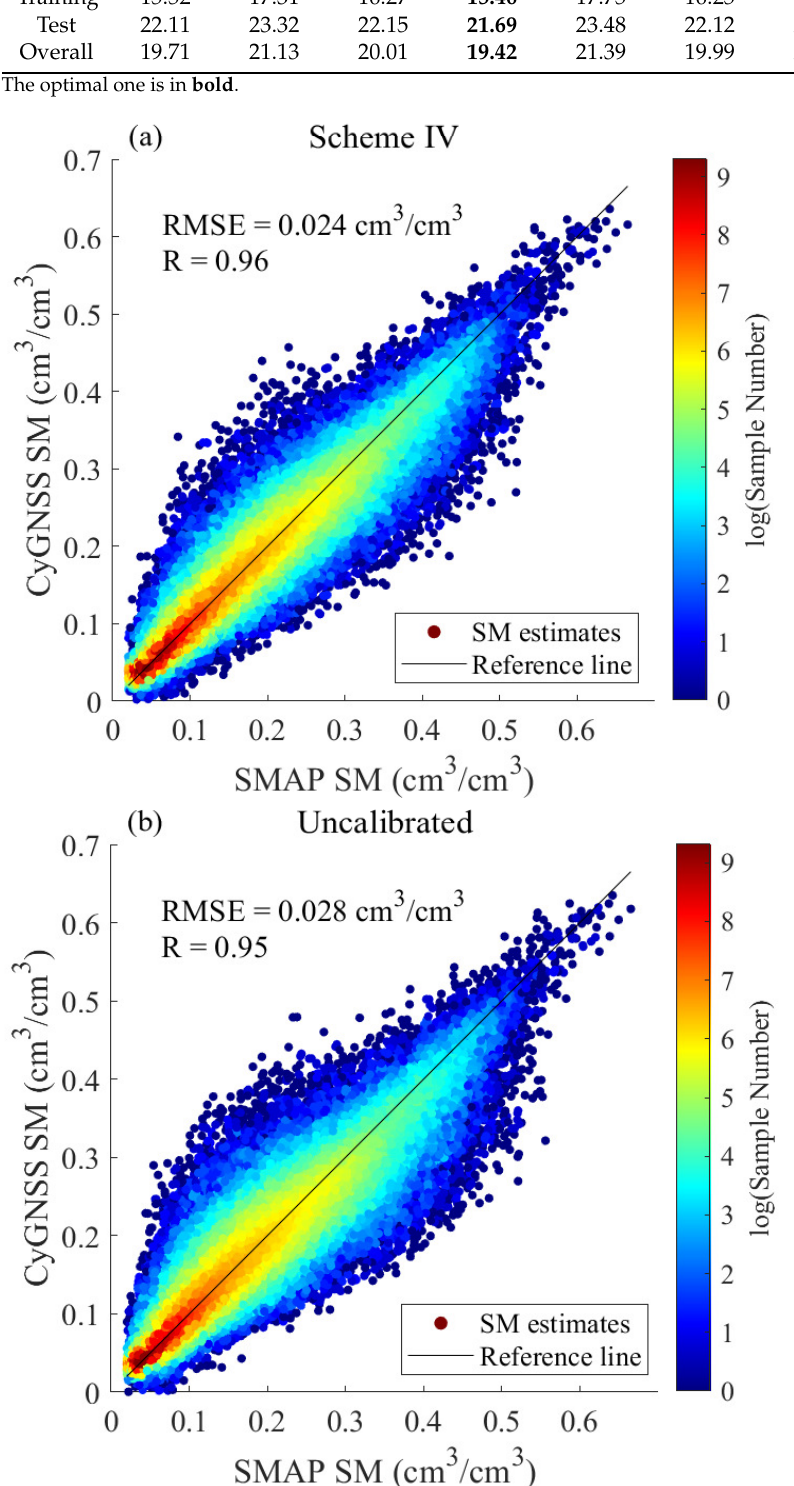
Figure 7. Density plot of SM retrievals using training data: ( a ) Scheme IV, and ( b )